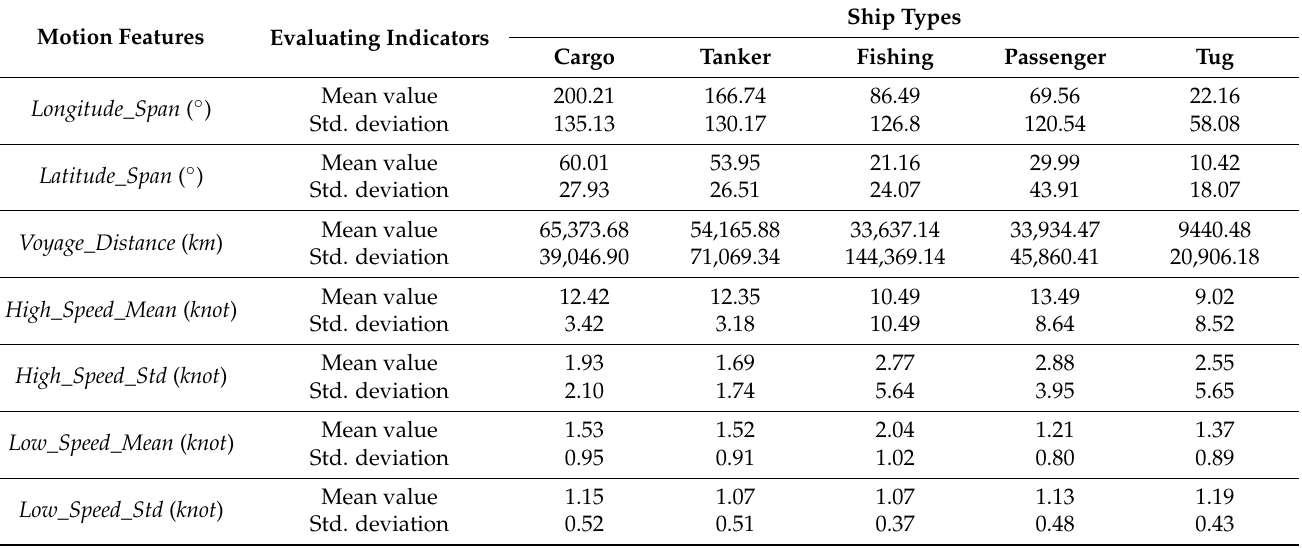
Table 4. The statistical results of ship behavior